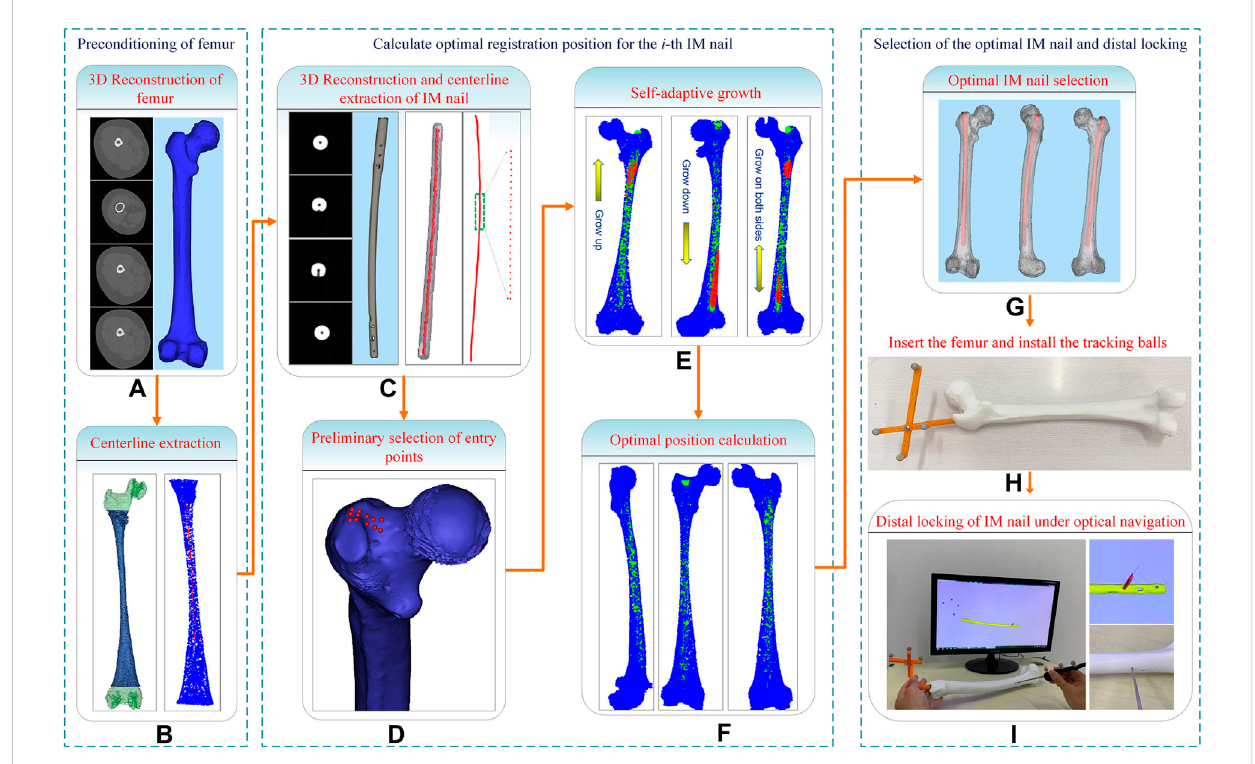
FIGURE 1 System fl ow chart of the computer-assisted preoperative selection